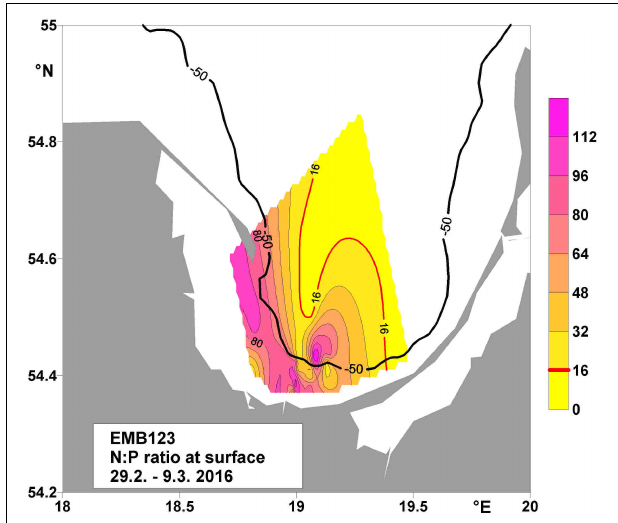
FIGURE 3 | Molar N:P ratio at the surface during cruise EMB123, in spring 2016. The bold line indicates the 50-m depth contour, and the red line the Redfield ratio of 16. The measured maximum was 7.8 times higher than the Redfield ratio.